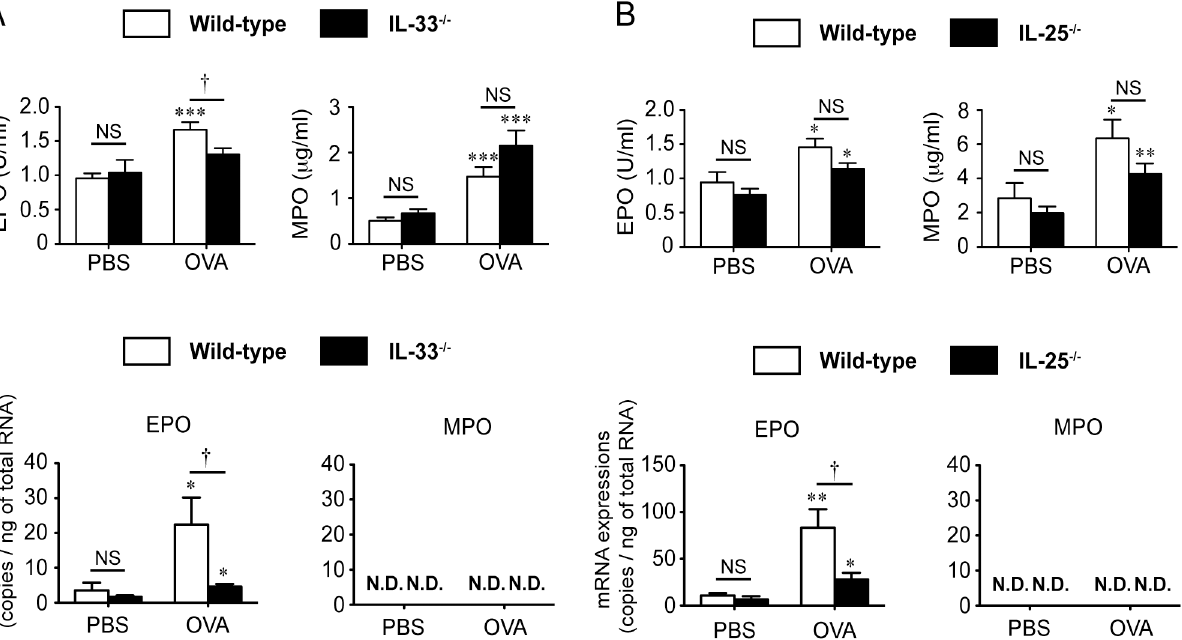
Fig 4. Contributions of IL-25 and IL-33 to eosinophil recruitment in lungs. The enzymatic activity and mRNA expression levels of EPO and MPO in BAL fluids and lungs, respectively, from wild-type (WT), IL-25 -/- mice and IL-33 -/- mice shown in Fig 3. Data are pooled from three independent experiments, each of which gave similar results. Data show the mean + SEM. * P < 0.05, ** P < 0.01 and *** P < 0.001 vs. the corresponding values for PBS-treated mice. † P < 0.05 and NS (not significant) vs. the indicated group (WT vs. IL-25 -/- , or WT vs. IL-33 -/- ).